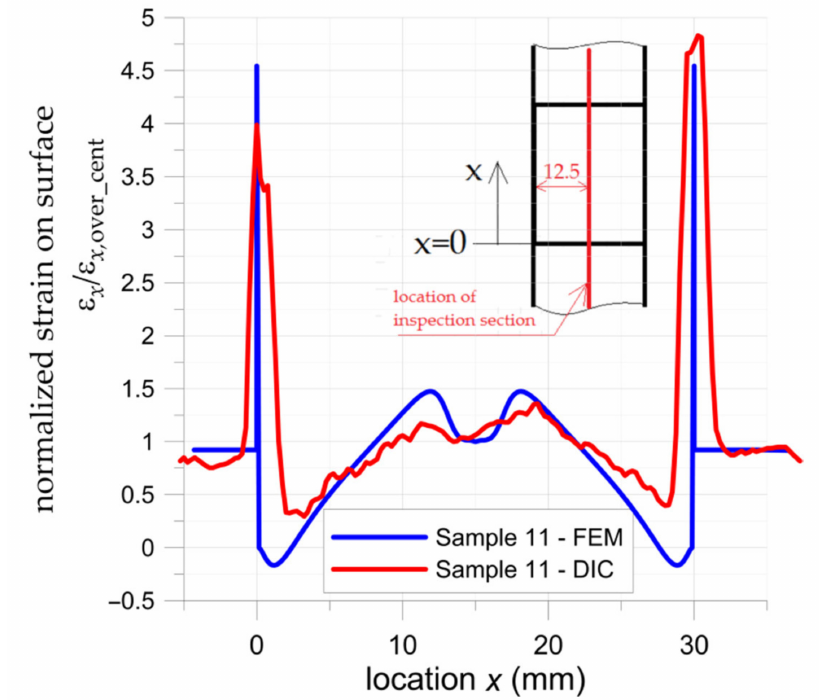
Figure 12. Distribution of normalized surface major strain in middle section of double-lap adhesively joint with S&P C-Laminate 150/2000 overlays—DIC and FEM